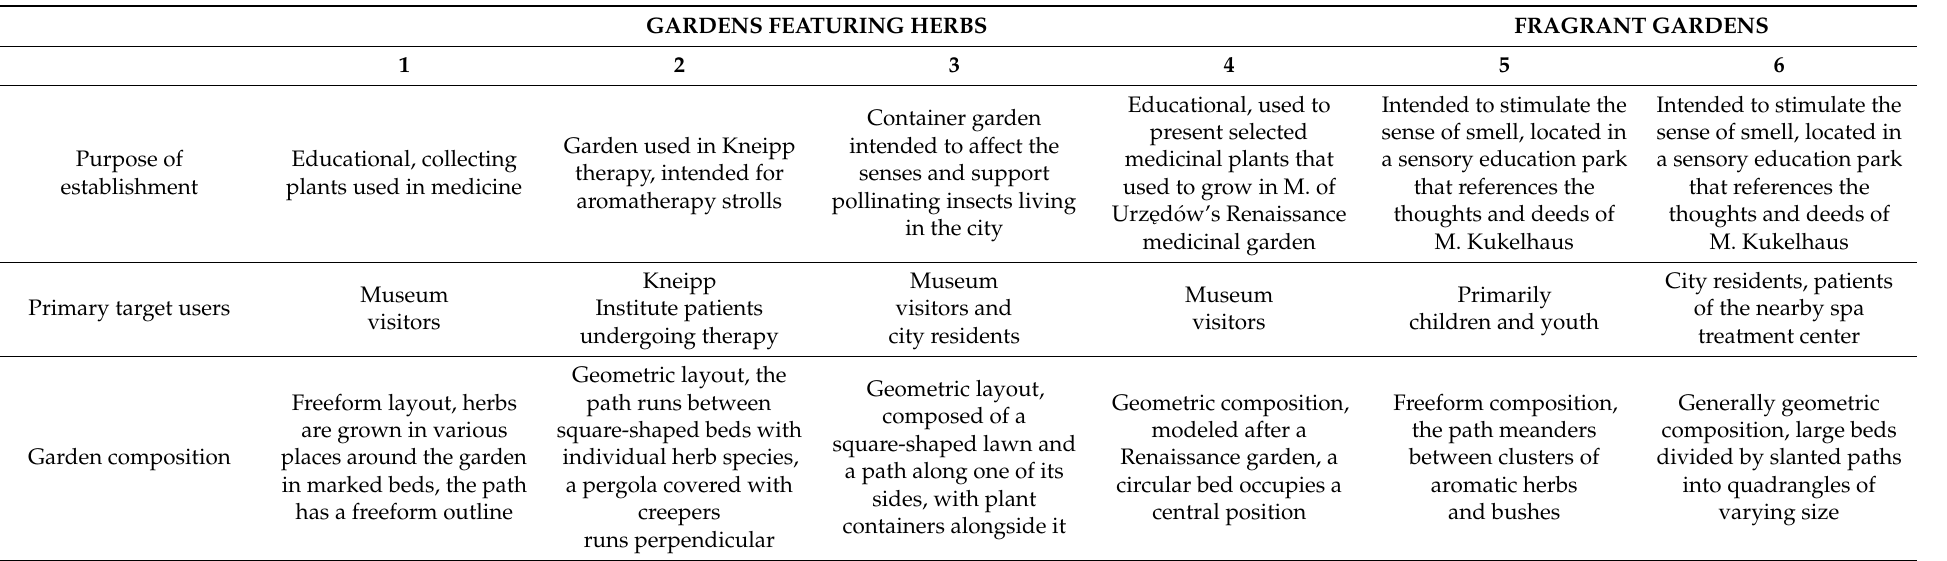
Table 1. Overview of the gardens under